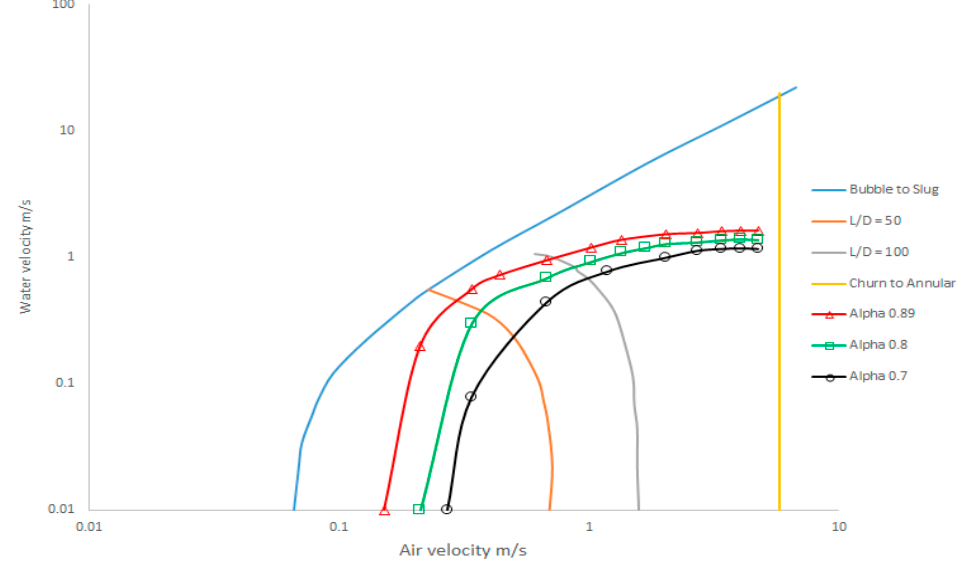
Figure 4. Comparison of experimental two-phase results by Taitel’s flow-pattern map.